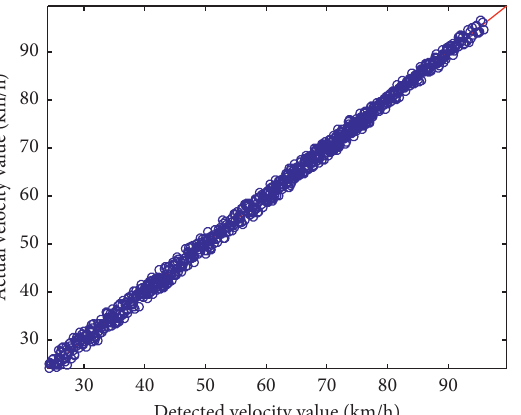
Figure 8: Actual velocity value and the detected velocity value calibrating based on the RBF neural network based on particle swarm optimization.